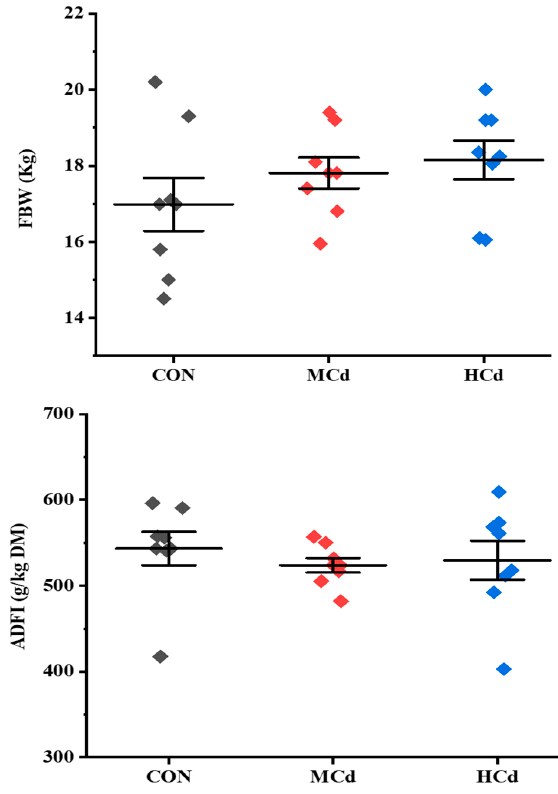
Figure 1. Effects of dietary cadmium levels on FBW, ADG, and ADFI of goats. FBW: final bodyweight gain; ADG: average daily gain; ADFI: average daily feed intake; treatments: CON, MCd, HCd: 0.23, 0.63, and 1.07 mg of Cd/kg of diet DM, respectively.